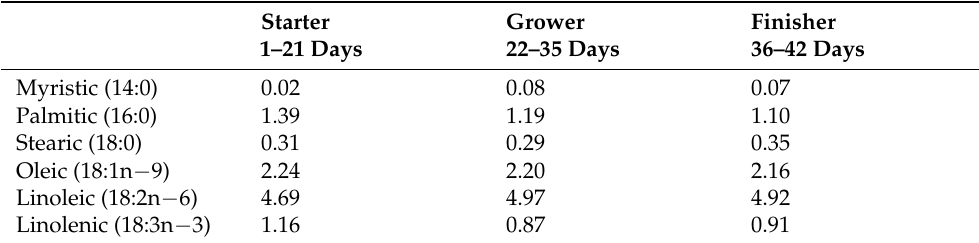
Table 3. Main fatty-acid profile of the basal mixtures, g/100